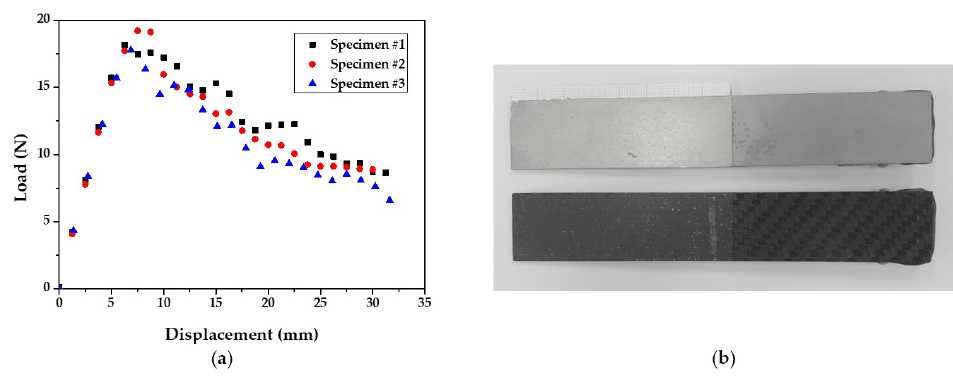
Figure 3. Results of DCB test: ( a ) load–displacement curve; ( b ) failure